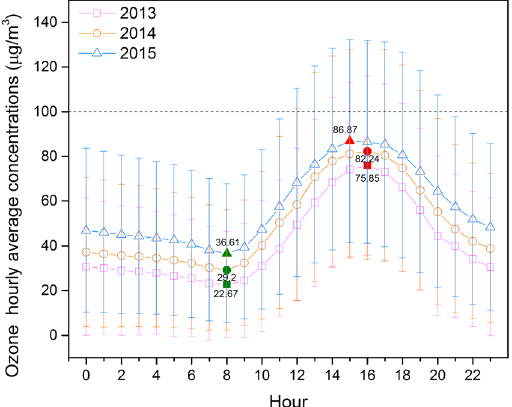
Figure 11. Hourly distribution of the maximum daily eight-hour average (MDA8) concentrations of ground- level ozone concentrations in sparsely populated regions during 2013–2015.